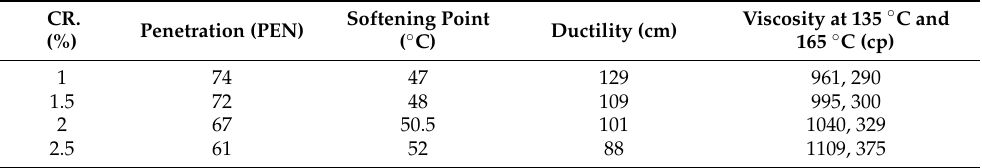
Table 3. Trials to determine the optimum crumb rubber content for the 25% RAPB + 2.7% WFO.